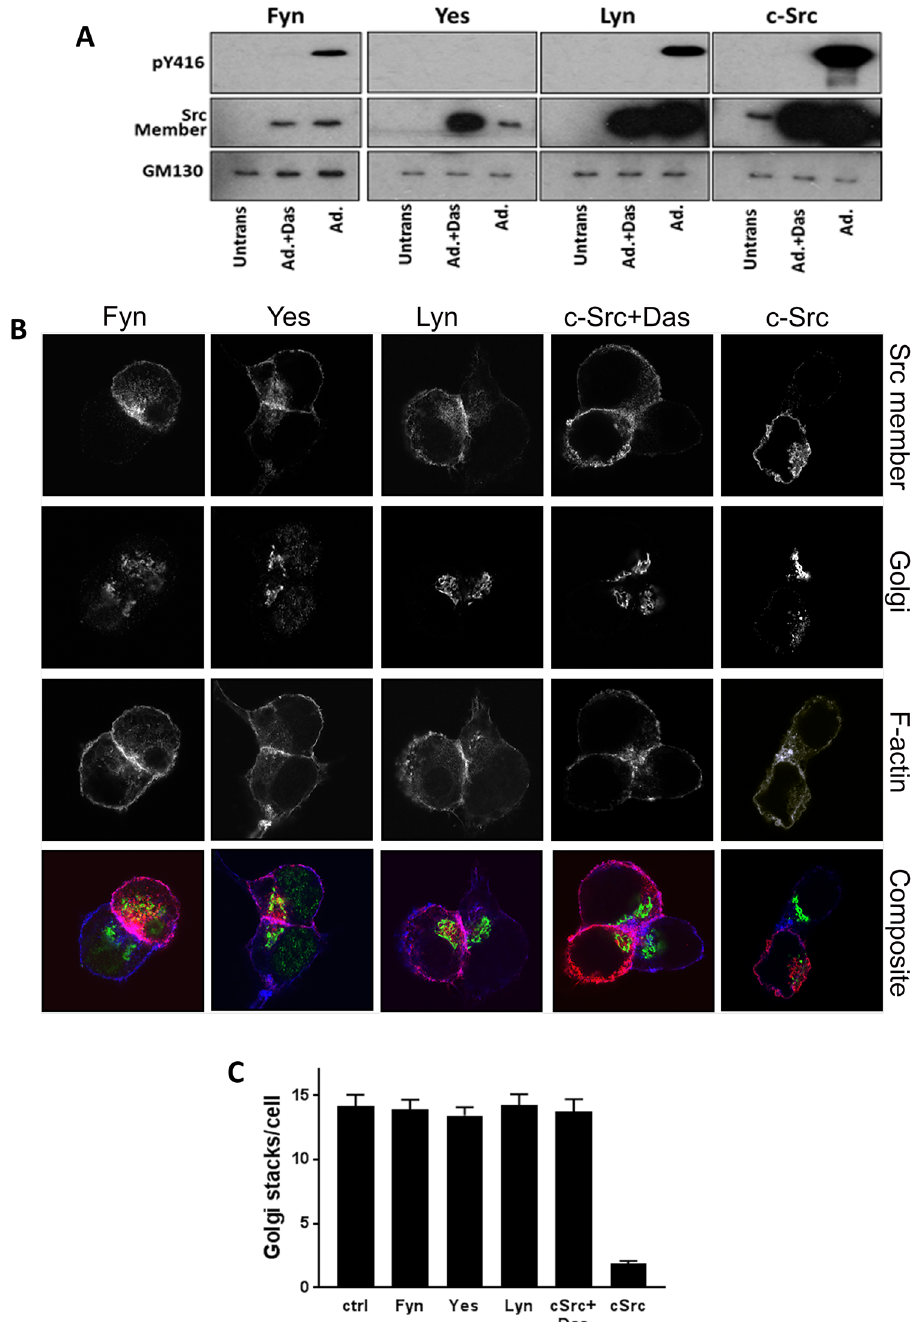
Figure 3. Effect of overexpression of different Src members on Golgi morphology. ( A ) Western blot of AR42J cell lysates overexpressing Fyn, Yes, Lyn and c-Src adenovirally with active Src (PY416) upper panel, Src family member (middle panel) and GM-130 as lower panel. Note that Yes is not activated on overexpression, and Dasatinib (Das) prevents Src activation. ( B ) Immunofluorescent images of adenovirally expressed Src member (upper panel), Golgi (second panel), F-actin (third panel) and composite image (Lower panel). Note, c-Src expressing cells has complete fragmentation of the Golgi, which was prevented by Dasatinib. ( C ) Bar graphs displaying the number of individual Golgi stacks in AR42J cells overexpressing Src members vs